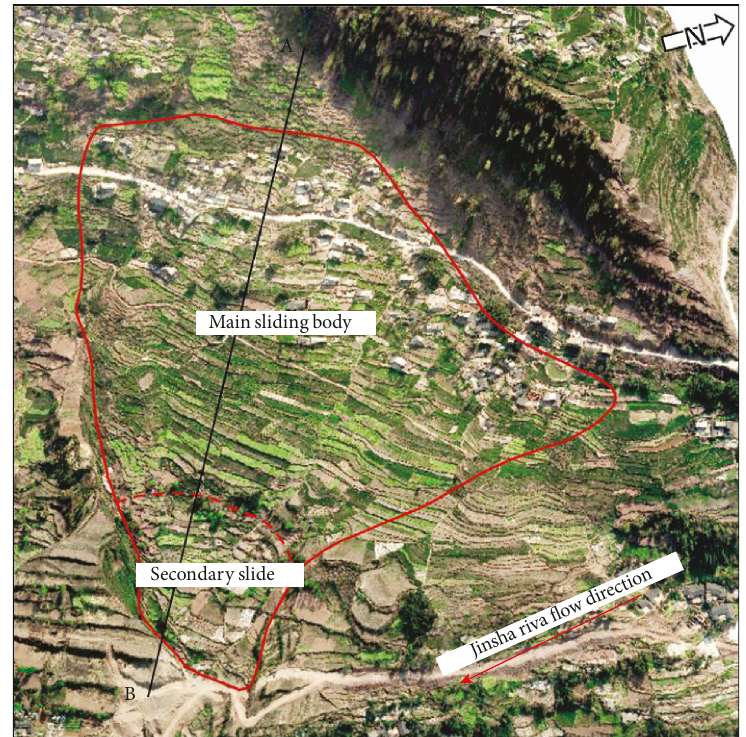
Figure 5: Remote-sensing image of Dasha